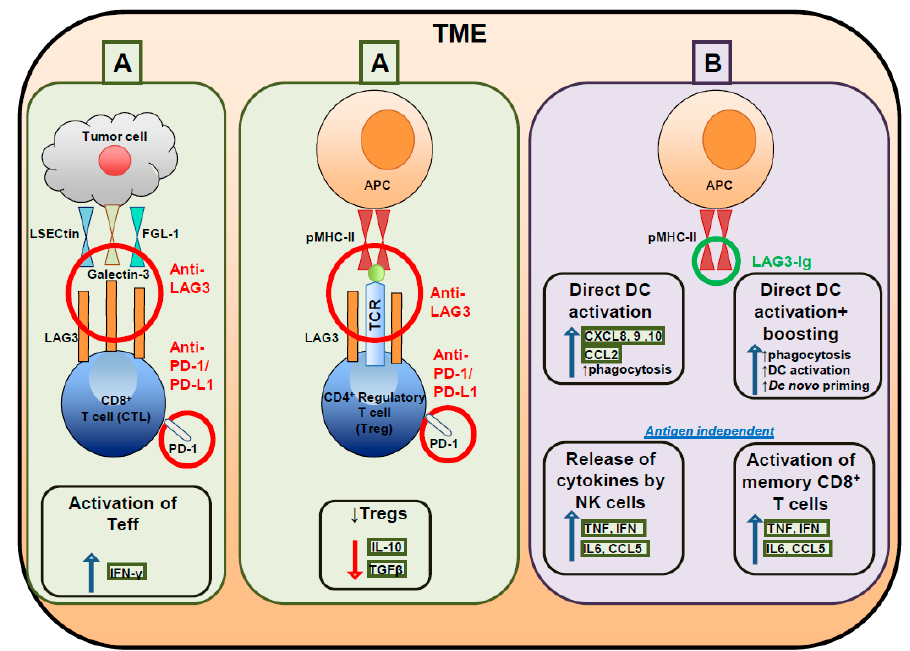
Figure 3. Targeting effector and regulatory T cells with LAG3 antagonistic antibodies ( A ) and activating antigen presenting cells with soluble LAG3 Immunoglobulin (Ig) ( B ). ( A ) Binding of LAG3 antagonistic antibodies (Abs) to LAG3 prevents its interaction with the respective ligands (LSECtin, galectin-3 and FGL-1 for CD8 + T cells; antigen presenting cells (APC) for CD4 + T cells). This contributes to releasing the break to the activation of tumor-infiltrating lymphocytes (TIL) and is achieved with the use of a combined blockade with anti-PD-1/PD-L1 Abs. ( B ) Binding of a soluble LAG3 Ig to APC engages MHC-II molecules on the cell surface. This generates an upregulation of co-stimulatory molecules, such as CD80, CD86 and CD40, and leads to the secretion of pro-inflammatory cytokines and chemokines by APC. APC activation through soluble LAG3 agonistic Ab may induce a rapid release of pro-inflammatory cytokines by a subpopulation of NK cells and activation of memory CD8 + T cells in an antigen independent manner. APC: Antigen presenting cell; CCL: chemokine (C-C motif) ligand; CXCL: chemokine (C-X-C motif) ligand; DC: dendritic cell; FGL-1: fibrinoigen like protein - 1; IFN: interferon; Ig: immunoglobulin; IL: interleukin; LSECtin: liver and lymph node sinusoidal endothelial cell C-type lectin; NK: natural killer; PD-1: programmed cell death -1; Teff: effector T cells; TNF: tumor necrosis factor; Tregs: regulatory T cells.